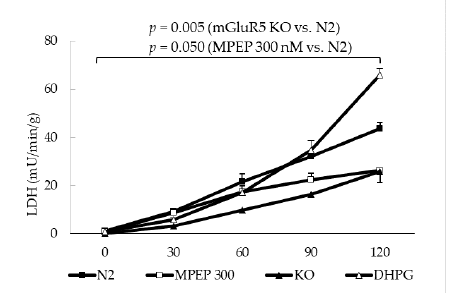
Figure 9. After 30 (cid:48) perfusion with anoxic medium at 37 ◦ C, during oxygenated warm reperfusion, the LDH release rate of control ischemic livers was significantly higher than livers treated with MPEP and livers from mGluR5 KO mice ( p = 0.05 and 0.005, respectively, in a linear mixed-effects fitting analysis). The addition of DHPG-DFB was not associated to changes in LDH release rate when compared to ischemic